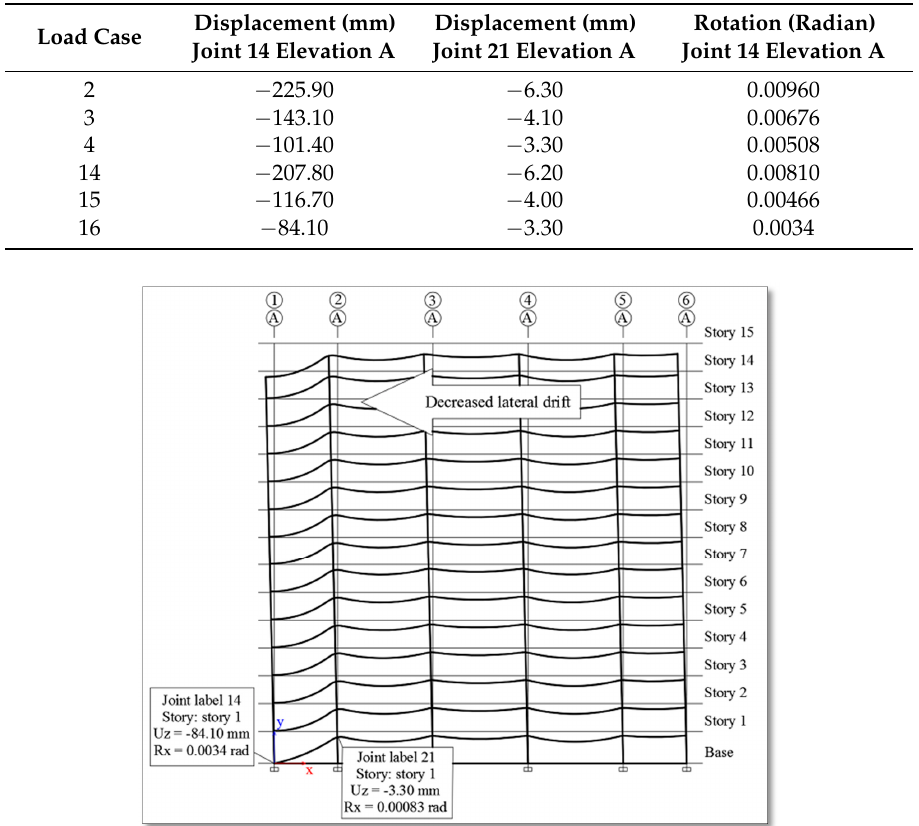
Table 7. Deformation response of the frame on gridline A obtained from AP analysis when corner column A1 is notionally removed.